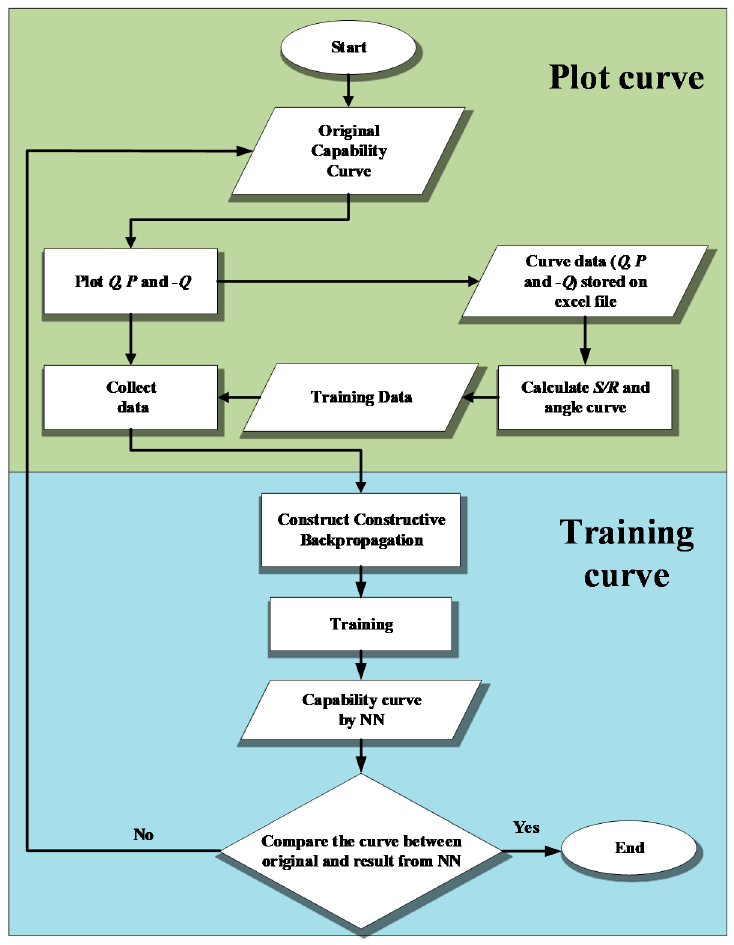
Figure 9. Flowchart of the generator capability curve formation.